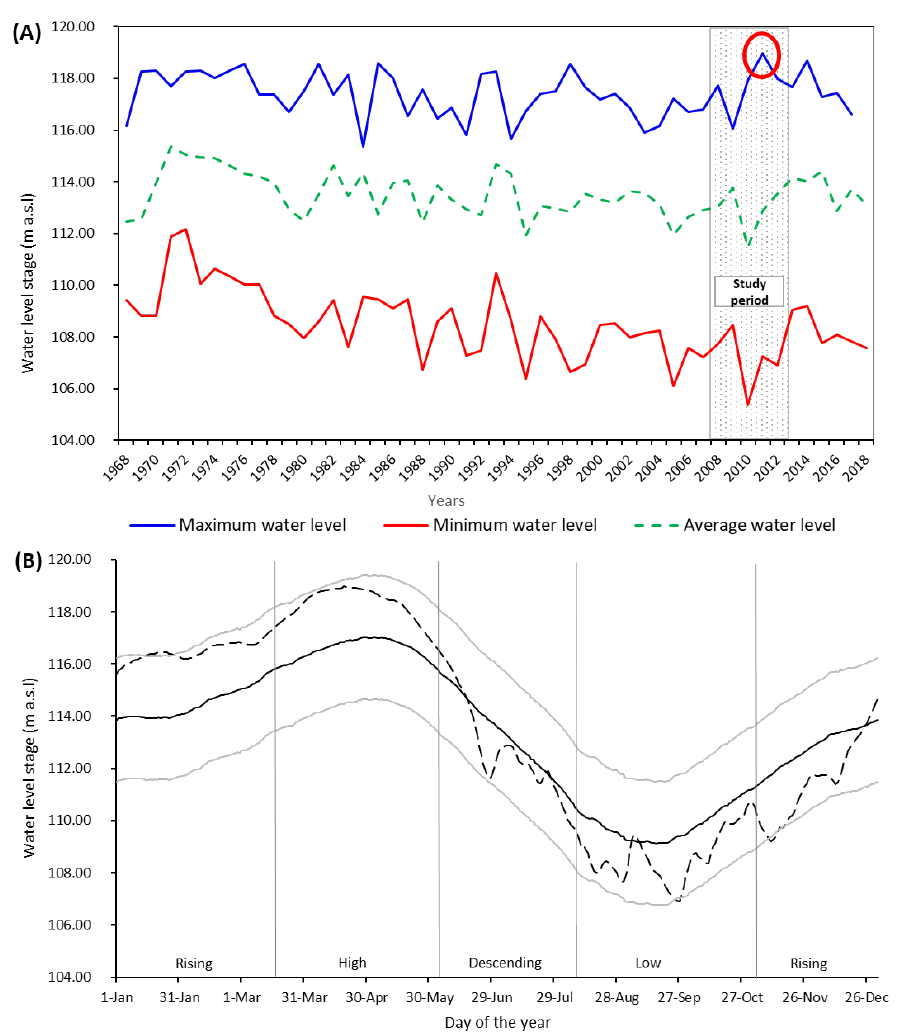
Figure 2. ( A ) The water surface elevation was measured for 50 years from 1968 to 2018 at the Iquitos gauging station. The maximum water level occurred in April 2012, of 118.97 ma.s.l., and the minimum was in October 2010, of 105.26 ma.s.l. ( B ) The dotted line illustrates the abnormally high-water levels in the 2012 flood. The solid line is the mean water elevation, and the gray lines show the 95% confidence interval of the water elevation based on the records measured in 1968–2018. The dashed line indicates the abnormally high water levels in the 2012 flood. Four stages are used to characterize the hydrograph, namely, the rising stage, high stage, descending stage, and low stage.